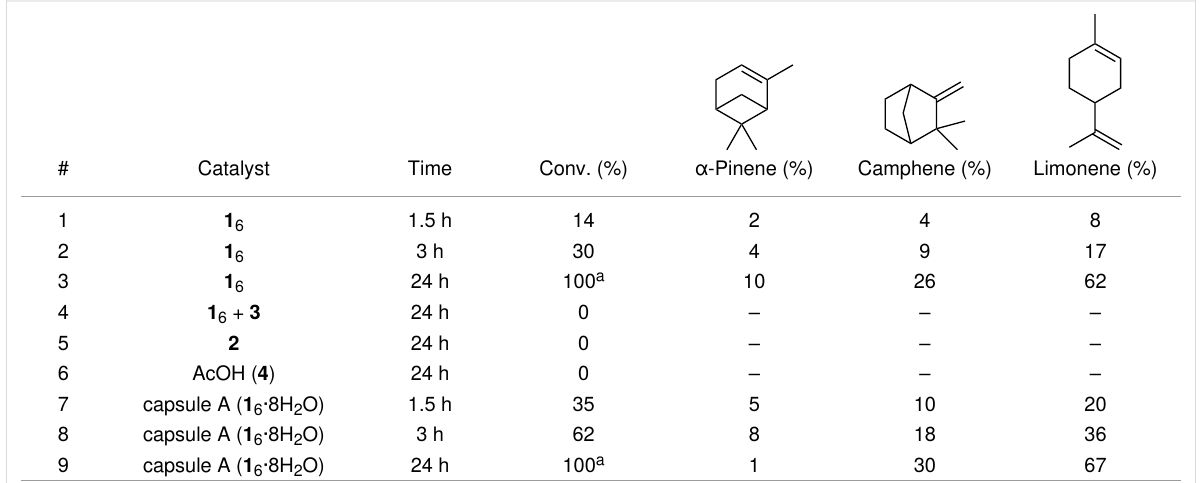
Table 4: Product distribution for the isomerization reaction of β -pinene at 60